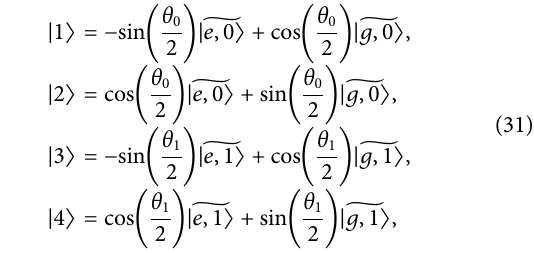
which yields a dark state decoupled with the open transmission line.